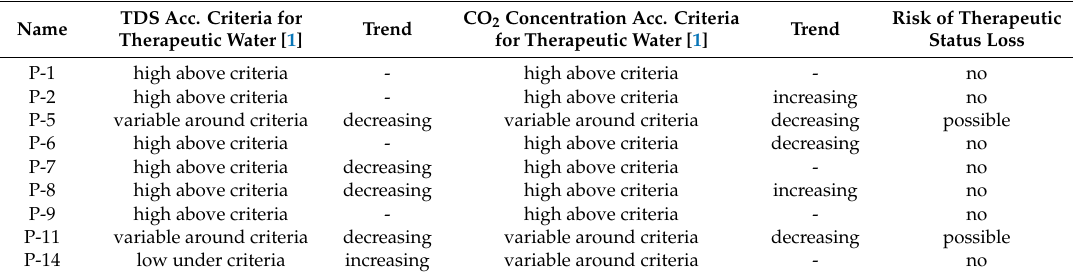
Table 2. Stability of analyzed